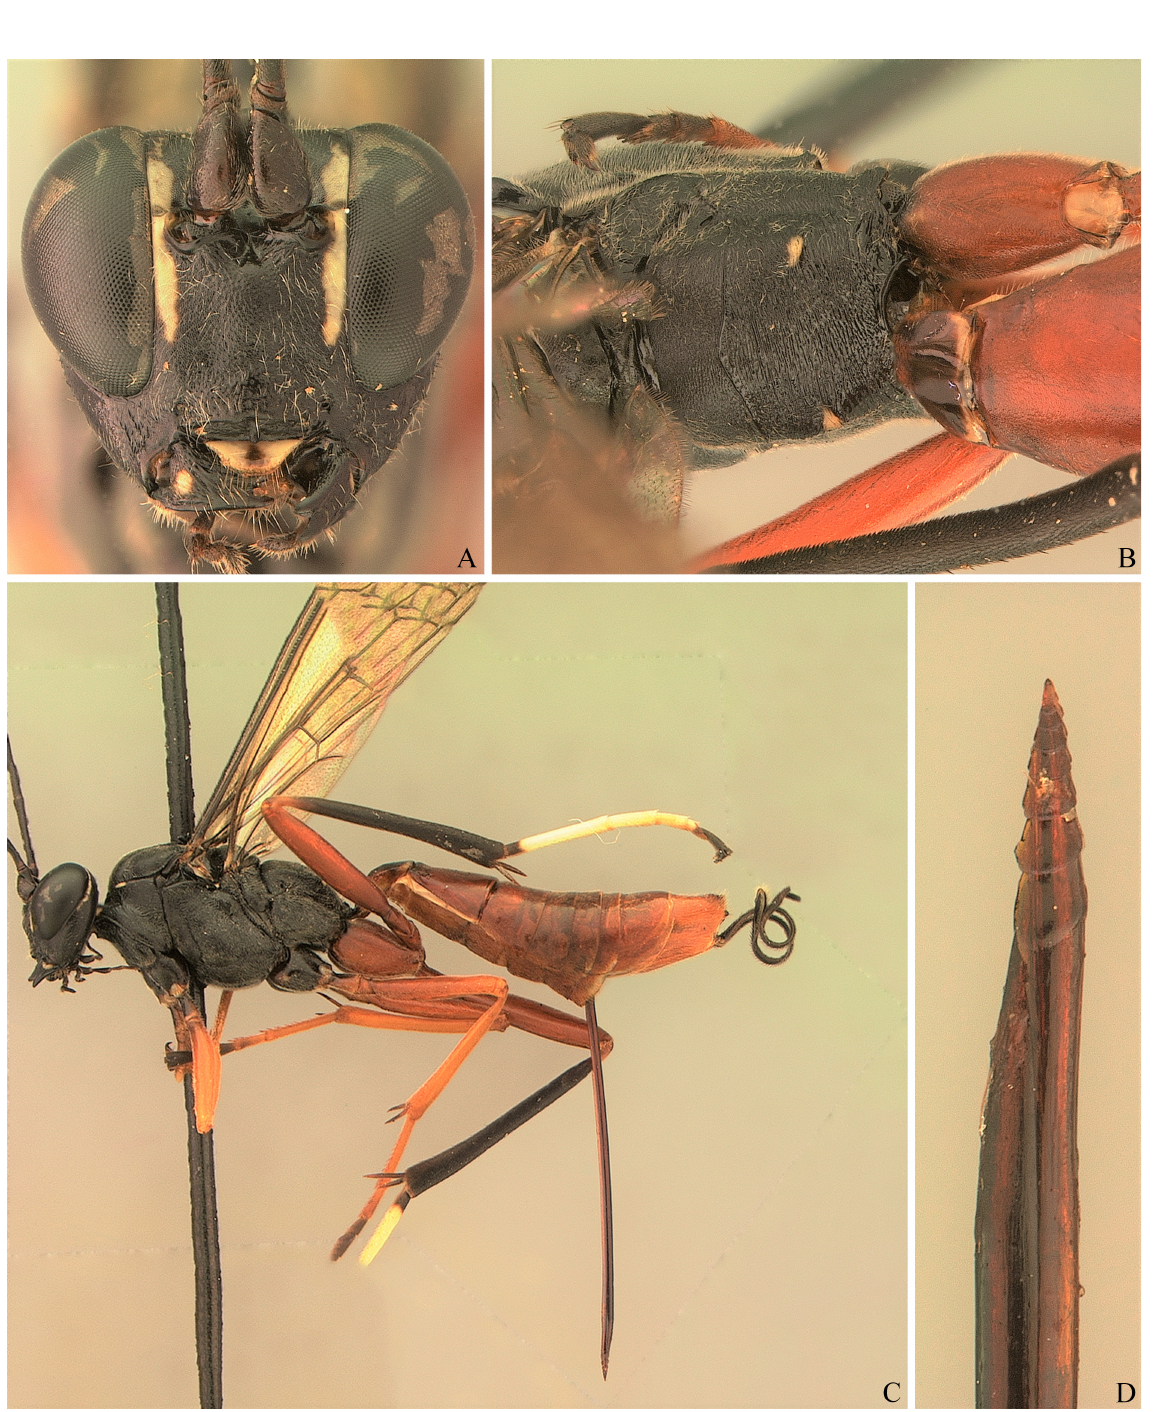
Fig. 5. Distictus ardens sp. nov., holotype (USUC), ♀. A . Head, frontal view. B . Propodeum + first two tergites, dorso-lateral view. C . Habitus. D . Apex of ovipositor,